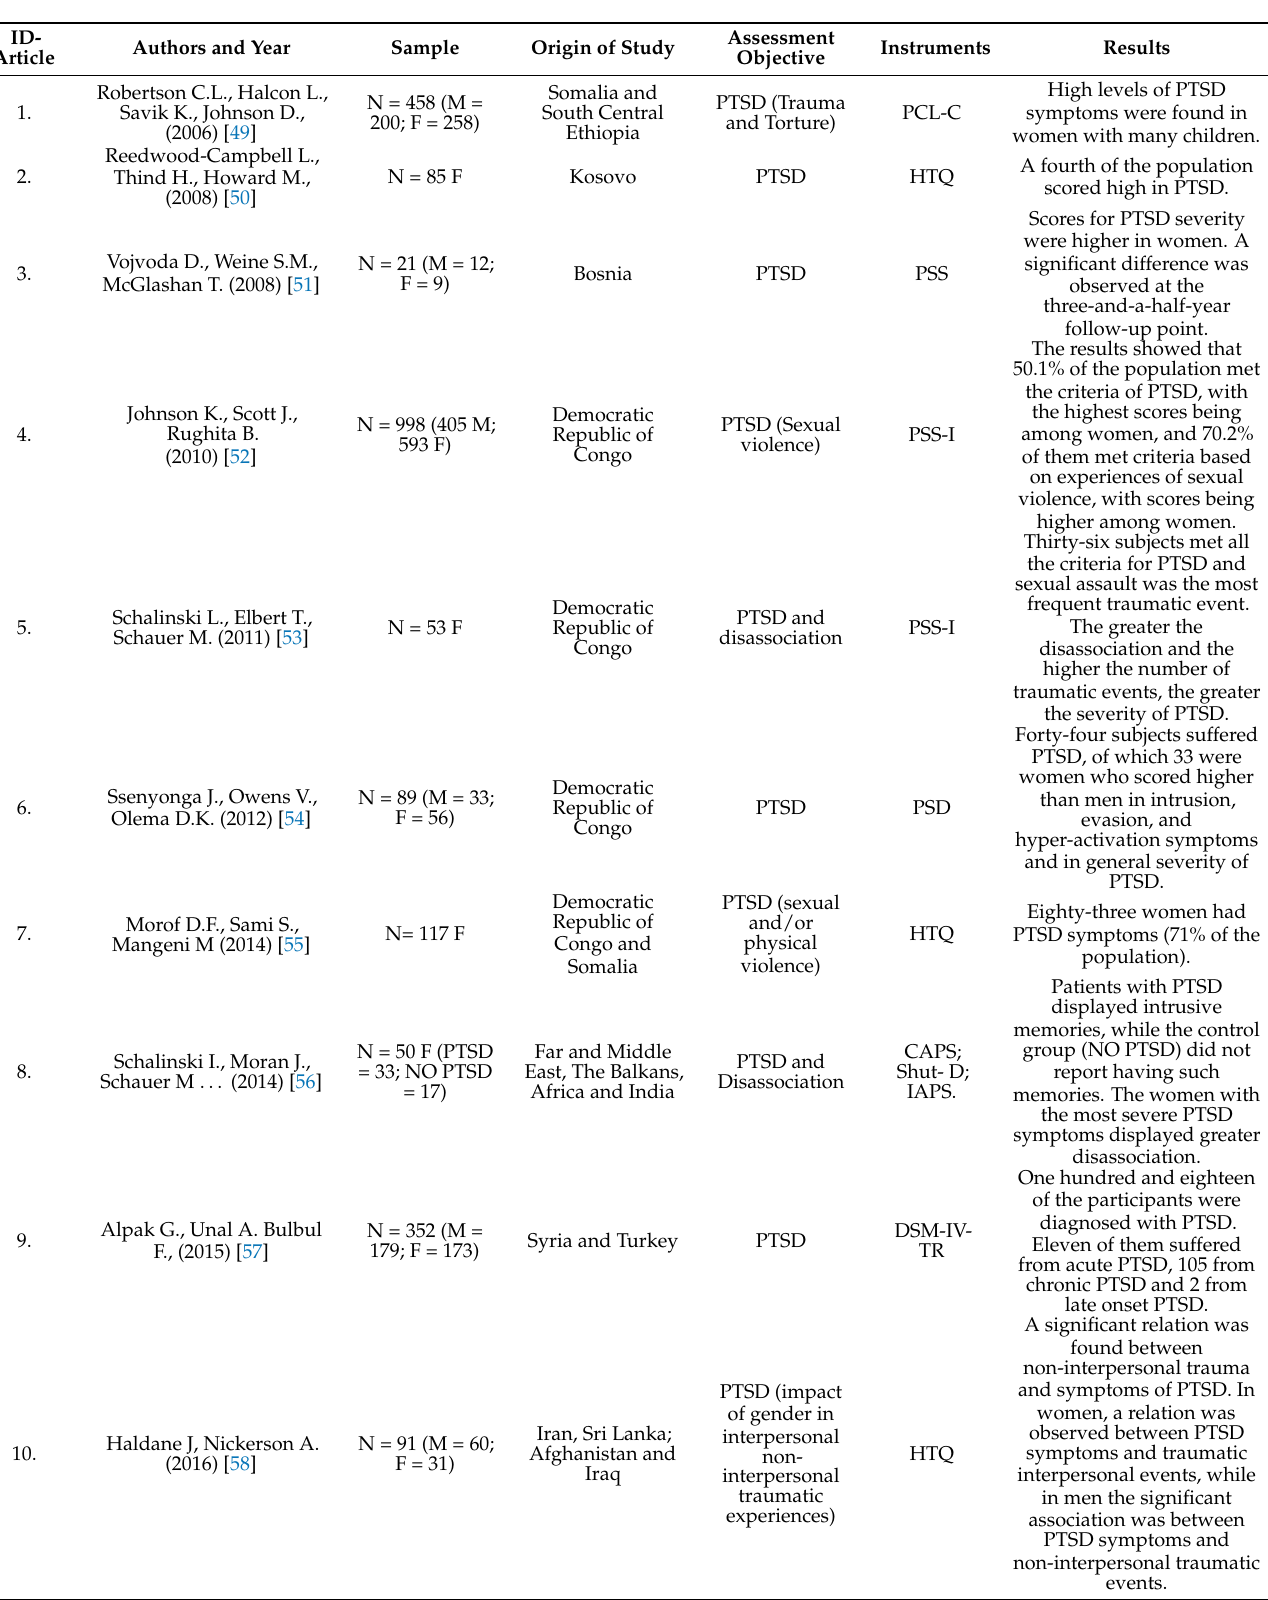
Table 1. Main results and characteristics of selected